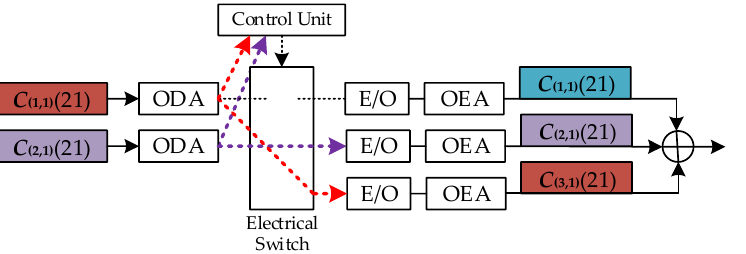
Figure 5. The optical buffering architecture with optical encoding/decoding of the CMLS. ODA: optical decoder array; OEA: optical encoder array; E/O: electrical-to-optical conversion.